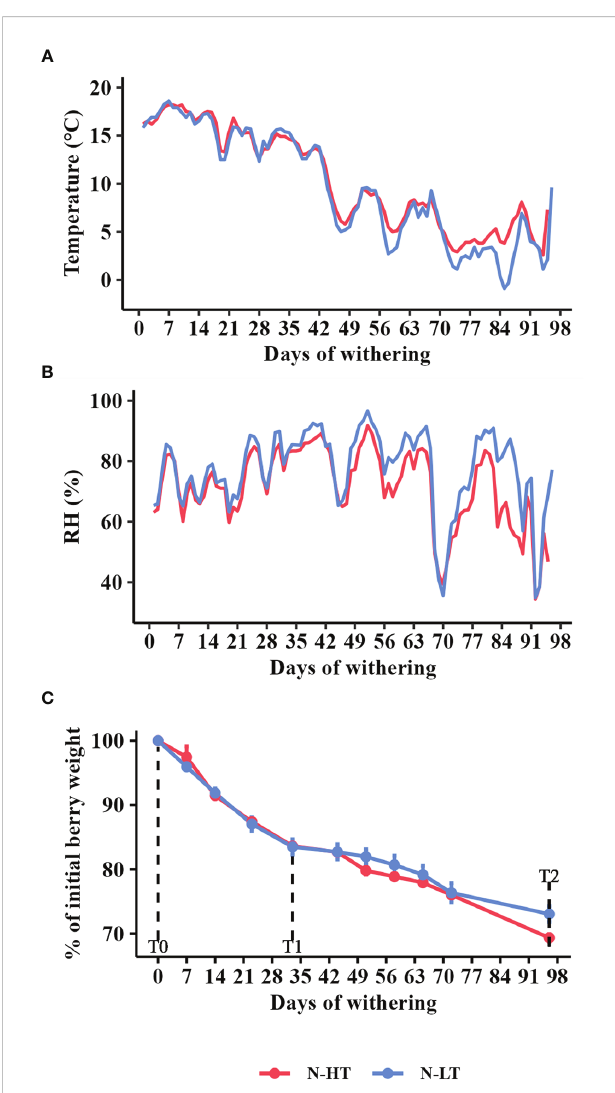
FIGURE 3 Postharvest dehydration in the naturally thermo-divergent N-HT and N-LT withering facilities. (A) Temperature and (B) Relative humidity (RH) registered in the facilities during withering. (C) Weight loss kinetics during withering in the N-HT and N-LT facilities reported as mean value ± SD of three biological replicates. For technological, metabolic and molecular analyses, grapes were collected during the withering processes at signed sampling time points corresponding to harvest time (T0), to ∼ 15% weight loss (T1) and to the end of withering (T2).